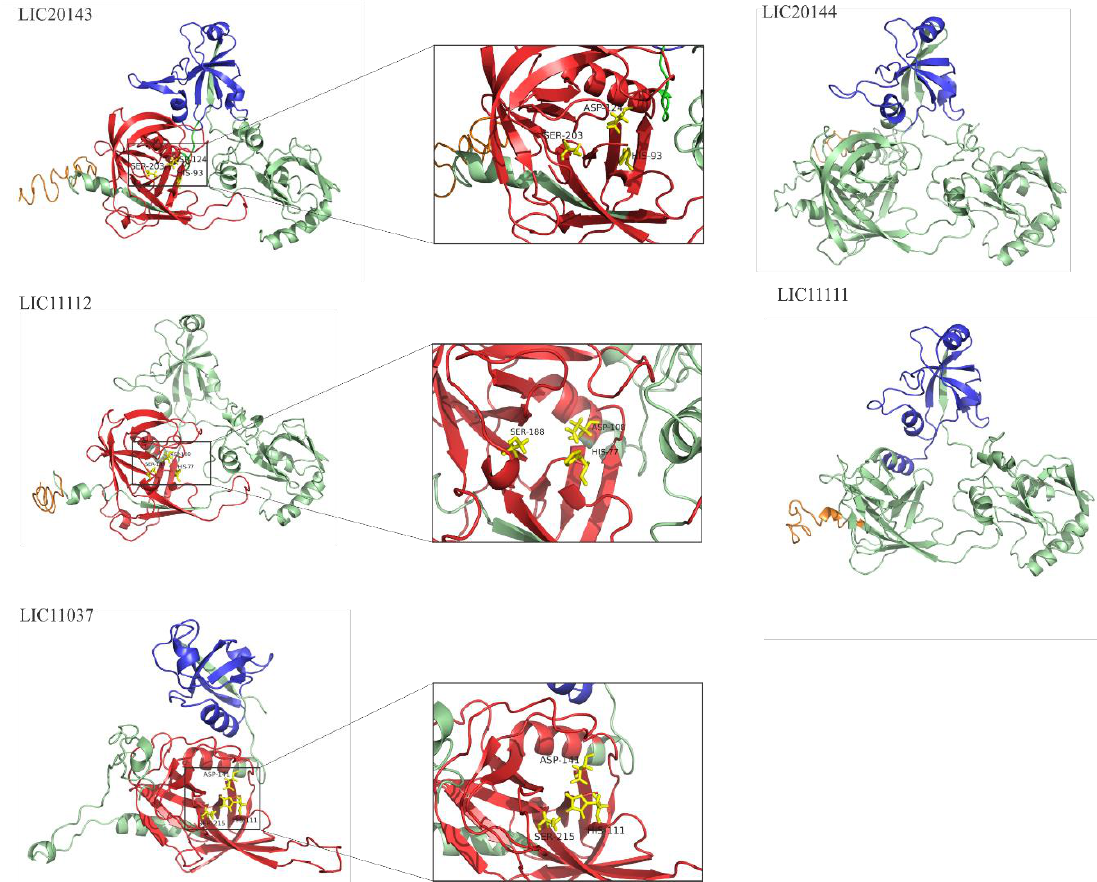
Figure 4. 3D theorical model of LIC20143, LIC20144, LIC11112, LIC11111, and LIC11037 from L. interrogans serovar Copenhageni. The 3D model was generated by I-TASSER and visualized by PyMOL. The regions in red represent the serine protease domain, in blue the PDZ domain and in orange the signal peptide region. The catalytic triad (histidine, aspartate, and serine; HDS) is represented as yellow sticks with the correspondent position number of the residue. The regions in green do not have any known function.